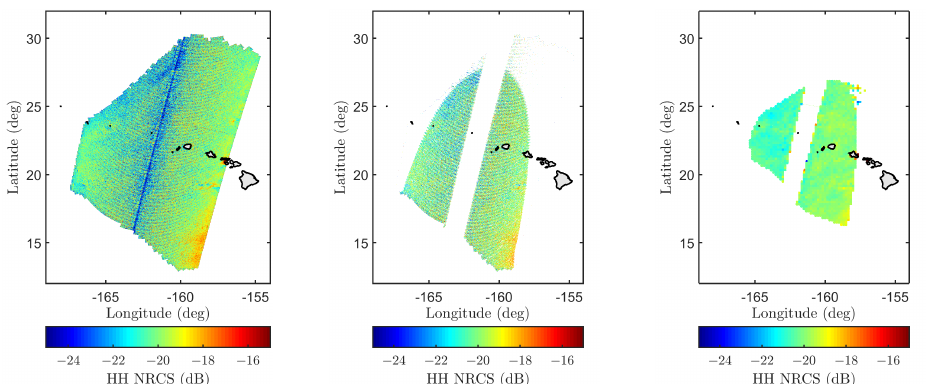
Figure 8. SMAP L1-C HH-polarized backscatter NRCS for orbit 01318D on 1 May 2015 over Hawaii. Figures from ( left ) to ( right ) show original SMAP measurements, high-fidelity measurements retained after applying quality flags, and SMAP NRCS degraded to ep_10m